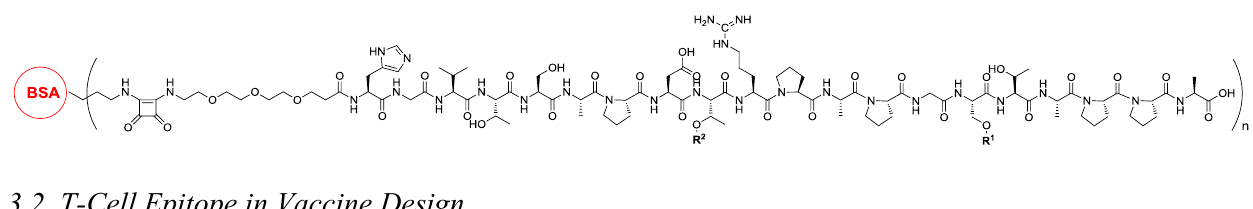
Figure 1. Li’s vaccine consisting of the glycopeptide antigen and the T-cell epitope [20].